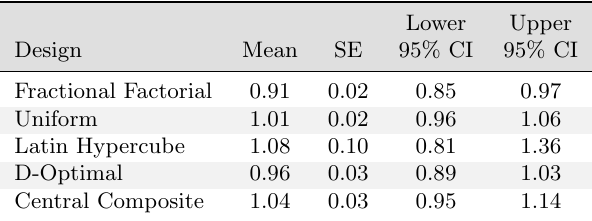
Table 4: Summary of the root mean square error (RMSE) values of the response surface models for the Plackett-Burman screening